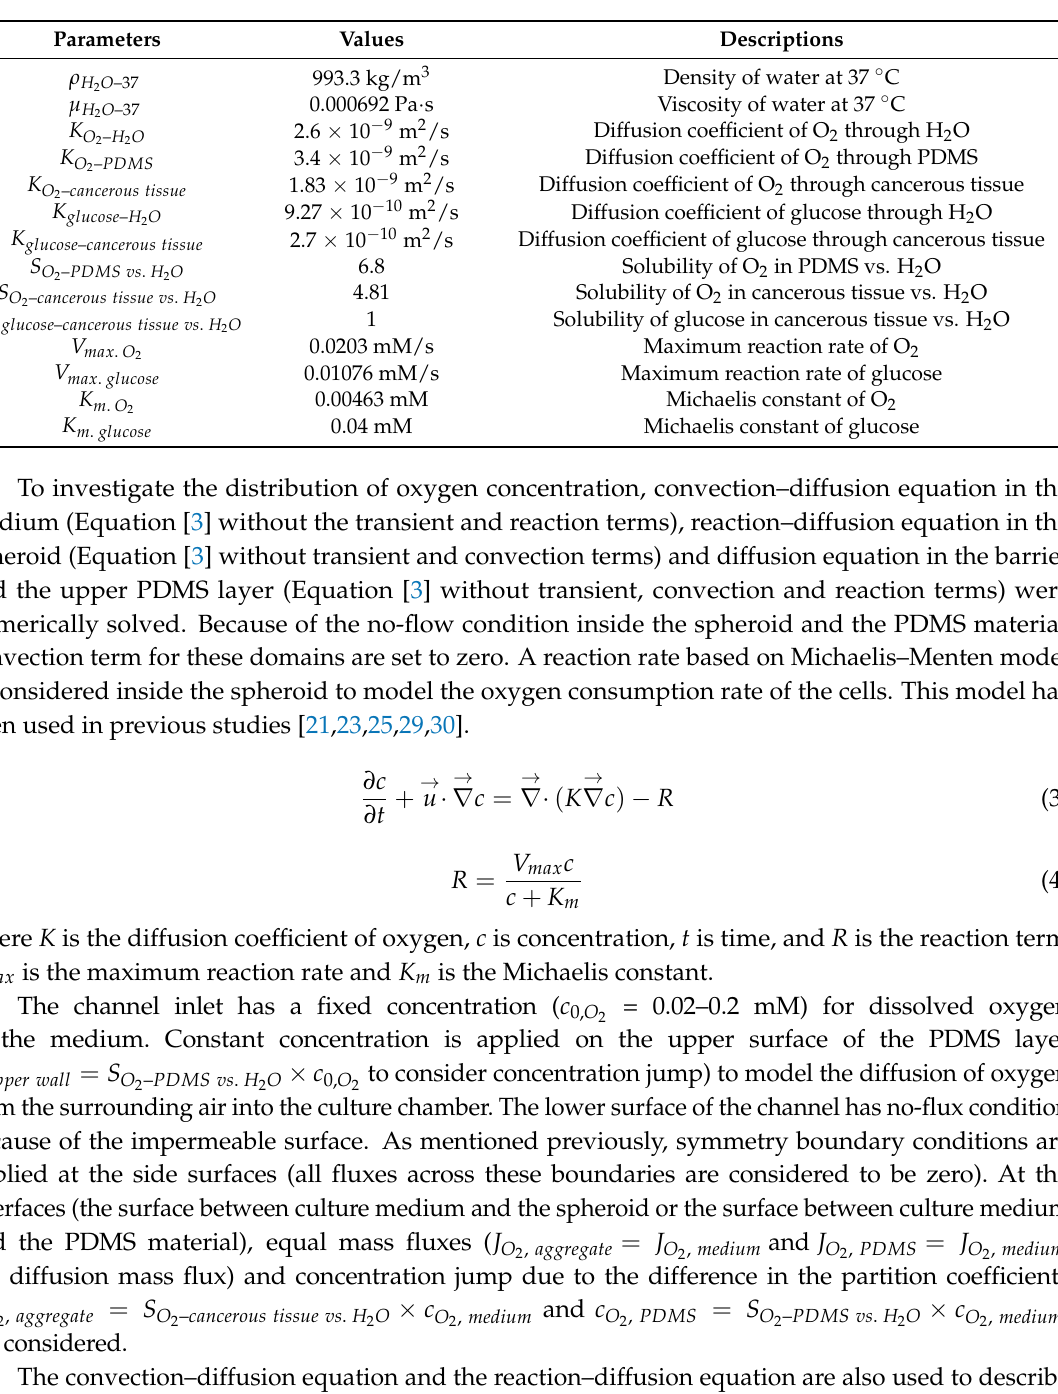
Table 2. The simulation properties